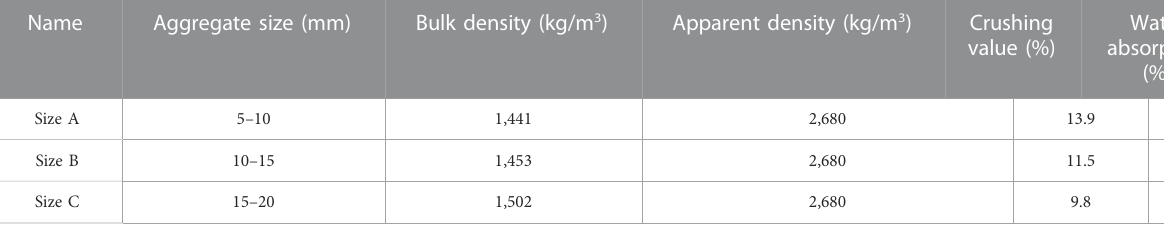
TABLE 2 Physical properties of natural coarse aggregate.